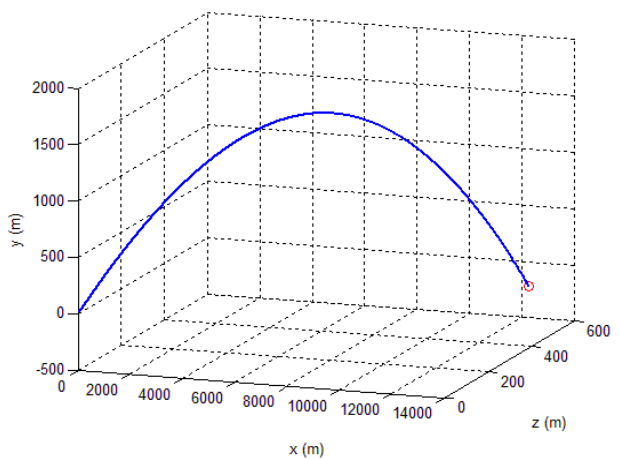
Figure 16. Trajectory of a spinning projectile.